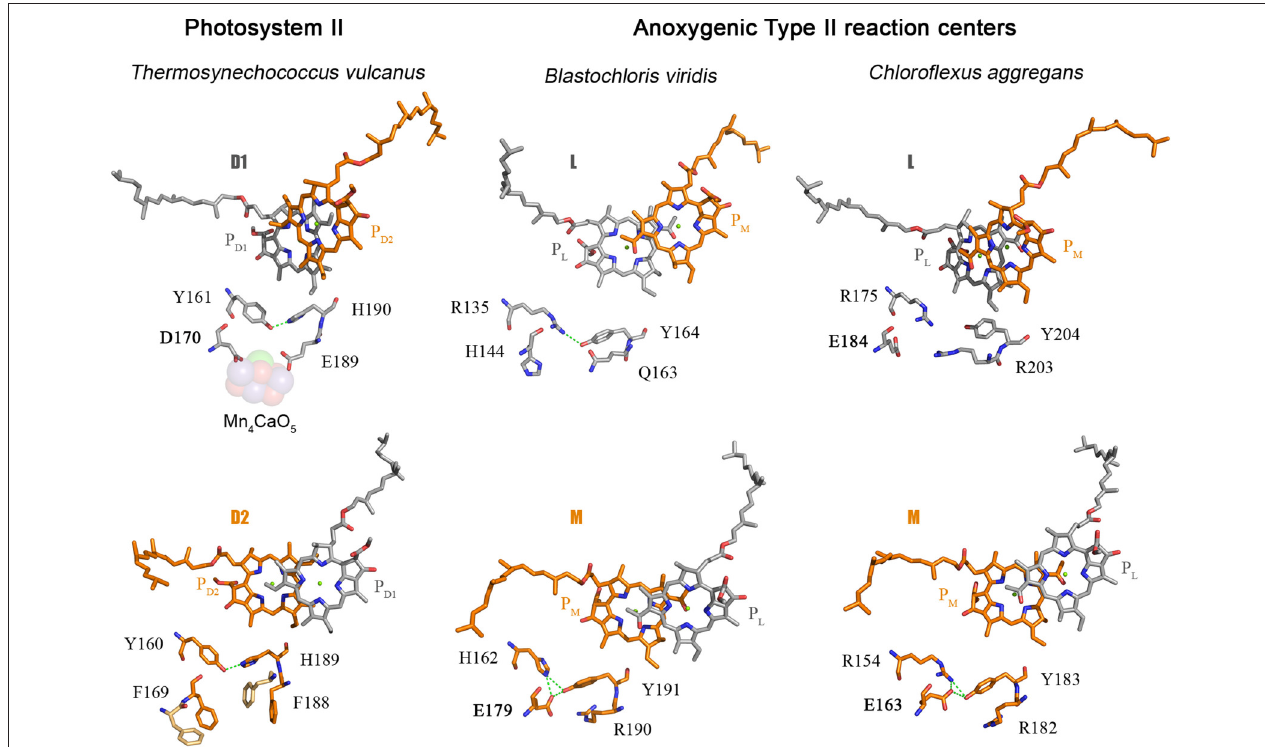
FIGURE 5 | Comparison of the electron donor sides of Type II reaction centers from Thermosynechococcus vulcanus (PDB ID: 3WU2), with those from Blastochloris viridis (PDB ID: 1JB0), and Chloroflexus aggregans . The highlighted residues are at strictly homologous positions as determined by sequence and structural comparisons; the variation in number is due to the fact that different reaction center proteins are of different sizes in different strains of bacteria. The L andM from Chloroflexus aggregans are homology models made with the SWISS-MODEL service, automated mode, using the structure of the Blastochloris viridis reaction center as a